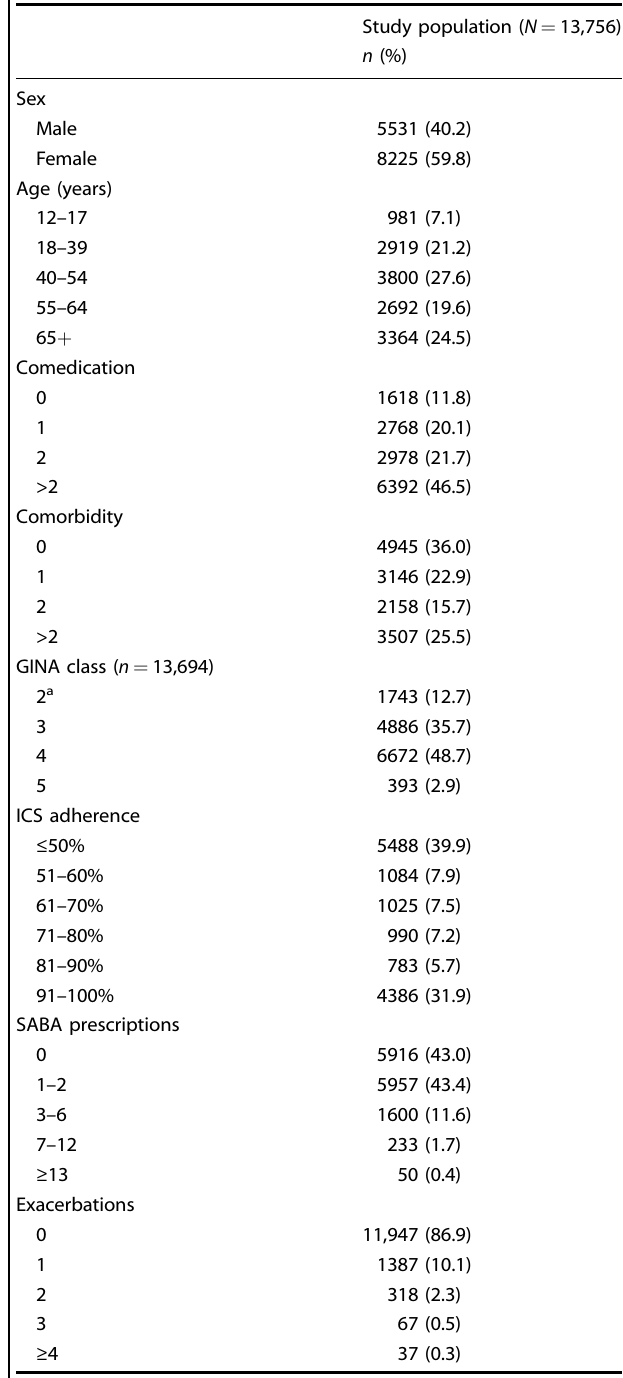
Table 1. Characteristics of the study population of Dutch primary care asthma